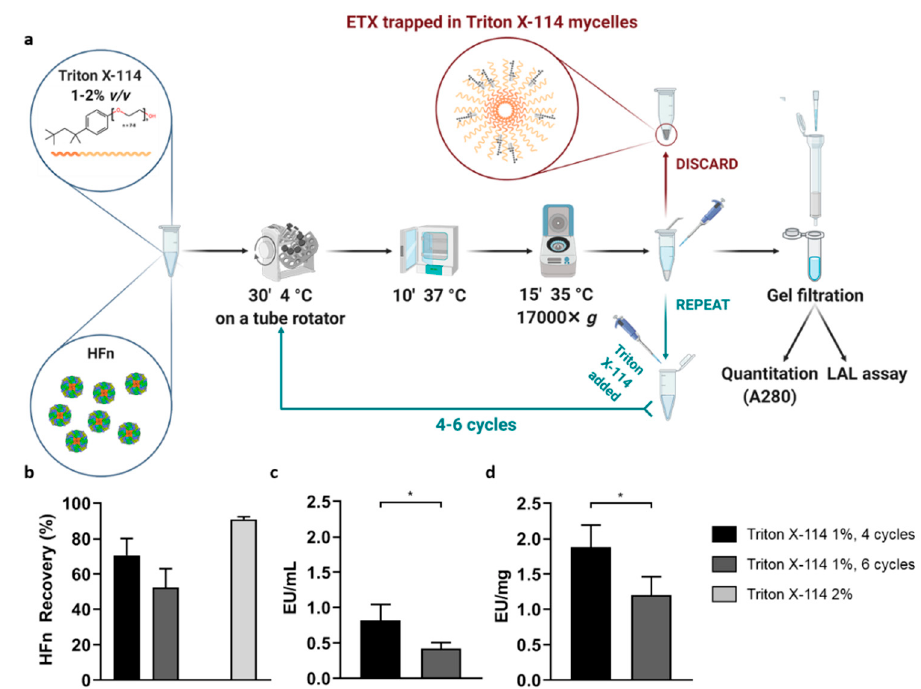
Figure 3. Purification strategy using Triton X-114. 1% of Triton X-114 has been added to HFn (1 mg/mL) and processed for 4 (black) or 6 (dark gray) purification cycles consisting of 30 ′ incubation at 4 °C followed by 10 ′ at 37 °C and centrifugation, as reported in panel ( a) . Also, a treatment with a single cycle of 2% Triton X-114 has been assessed (light gray). HFn recovery in each condition was calculated by absorbance reading ( b ); ETX levels have been obtained by Limulus Amebocyte Lysate (LAL) test ( c , d ). Results are reported as average ± S. D. of 6 independent experiments. Statistical significance: panel c: * p = 0.0263; panel d: * p =